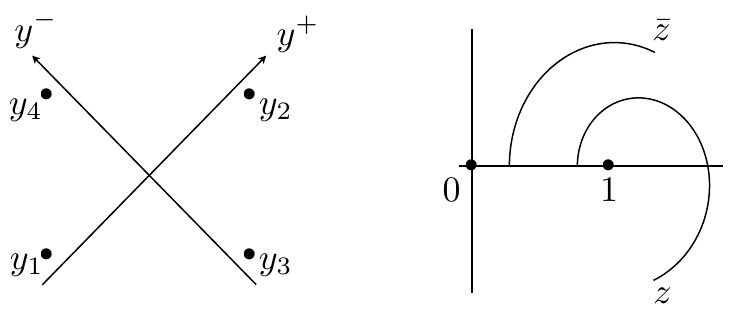
Figure 2 . Regge kinematics requires y 2 ; y 2 > 0 and y 2 ; y 2 < 0. The left panel shows the Regge 13 24 14 23 kinematics for y 2 ; y 2 > 0, but that is not necessary since we may allow y 2 to cross the light cone 12 34 of y 1 and y 4 the light cone of y 3 . The right panel shows the path of the cross ratios z; (cid:22) z as we analytically continue from the Euclidean region to the Lorentzian